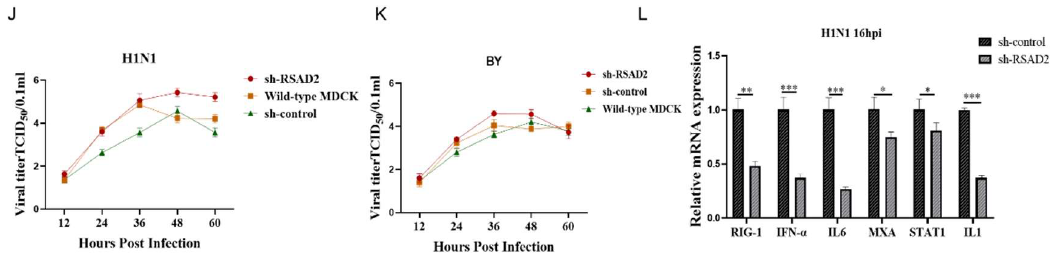
Figure 5 . Knockdown of RSAD2 promotes influenza virus proliferation. ( A ) RSAD2 gene expression was detected in MDCK cells infected with IAV H1N1 at 0, 12, 24, 36, 48, and 60 h post infection (hpi) using qPCR. ( B ) RSAD2 protein expression was detected in MDCK cells infected with IAV H1N1 at 0, 24, 48, and 60 hpi using western blot. ( C ) Representative images of sh-RSAD2 with a GFP tag using a 40× fluorescence microscope are shown. ( D ) Protein expression of RSAD2 in sh-RSAD2 MDCK cells was measured using western blot to verify successful knockdown. ( E ) Gene expression of RSAD2 in sh-RSAD2 (#1, #2, #3) MDCK cells was measured using qPCR to verify successful knockdown. ( F ) The proliferation of sh-control and sh-RSAD2 cells was detected using the digestion technique. ( G ) Influenza A/Puerto Rico/8/34 (A/PR/8/34) H1N1 virus, A/Texas/50/2012 (H3N2) NYMCX-223A, B/Colorado/06/2017-like virus B (Victoria lineage), and B/Phuket/3073/2013-like virus B (Yamagata/16/88 lineage) NP gene expression were measured in sh-RSAD2 MDCK cells using qPCR. ( H,I ) Influenza A/Puerto Rico/8/34 (A/PR/8/34) H1N1 virus, A/Texas/50/2012 (H3N2) NYMCX-223A, B/Colorado/06/2017-like virus B (Victoria lineage), and B/Phuket/3073/2013-like virus B (Yamagata/16/88 lineage) NP protein expression were measured in sh-RSAD2 MDCK cells using western blot. ( J , K ) Growth kinetics of the influenza A/Puerto Rico/8/34 (A/PR/8/34) H1N1 virus, A/Texas/50/2012 (H3N2) NYMCX-223A, B/Colorado/06/2017-like virus B (Victoria lineage), and B/Phuket/3073/2013-like virus B (Yamagata/16/88 lineage) vaccine strain by TCID 50 method. ( L ) Antiviral factor gene expression was measured in sh-RSAD2 MDCK cells using qPCR. GAPDH was used as the reference gene for qPCR and GAPDH was used as the loading control for western blot. * Was used to determine statistically significant differences between groups; * p < 0.05, ** p < 0.01, *** p < 0.001).